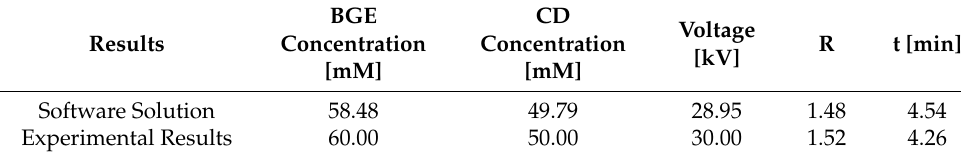
Table 3. Software solution vs. experimental results for the chiral separation of